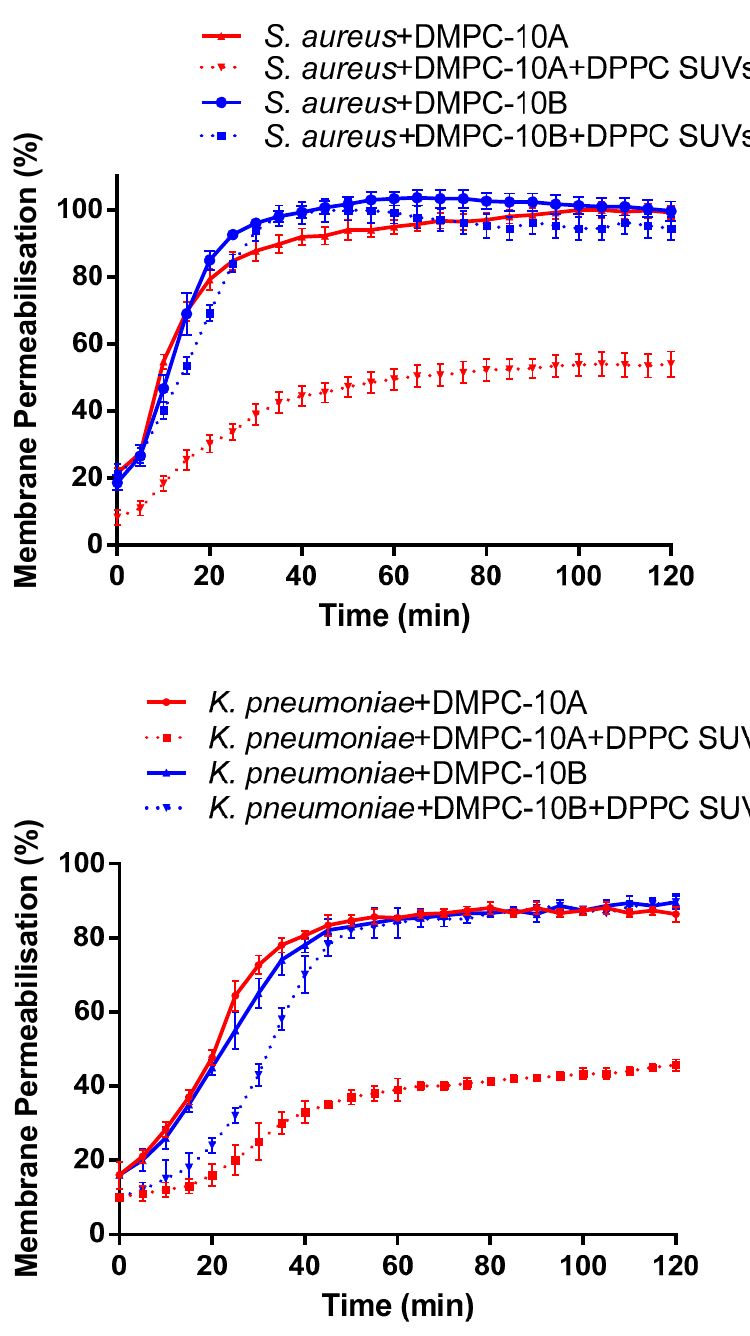
Figure 5. Kinetics of membrane permeabilization of DMPC-10A and DMPC-10B on S. aureus (NCTC 10788) and K. pneumoniae (ATCC 43816) at 16 µ M. To determine the lipid selectivity of both peptides, 1 mg / mL of dipalmitoylphosphatidylcholine (DPPC) small unilamellar vesicle (SUVs) was added. The percentage of membrane permeabilization was measured using the bacterial cells treated with 70% isopropanol. The error bar represents the standard deviation (SD) of five replicates.